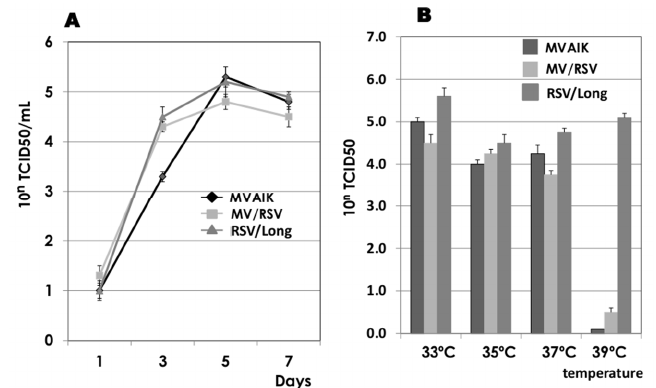
Figure 2. Virus growth of MVAIK, MV/RSV, and RSV/Long and comparison of virus growth at different temperatures. ( A ) Vero cells were infected with MVAIK, MV/RSV, and RSV/Long and culture fluids were harvested at 1, 3, 5, and 7 days after infection. Vertical lines show the mean ± error bar of three experiments. ( B ) Virus infectivity on day 5 of infection at different temperatures of 33, 35, 37, and 39 ◦ C. Vertical columns show the infective virus titer of mean + error bar of three